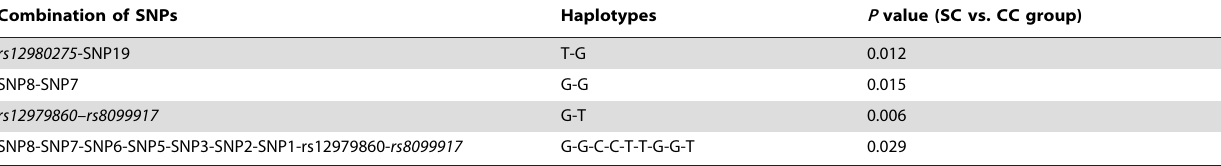
Table 4. Haplotypic